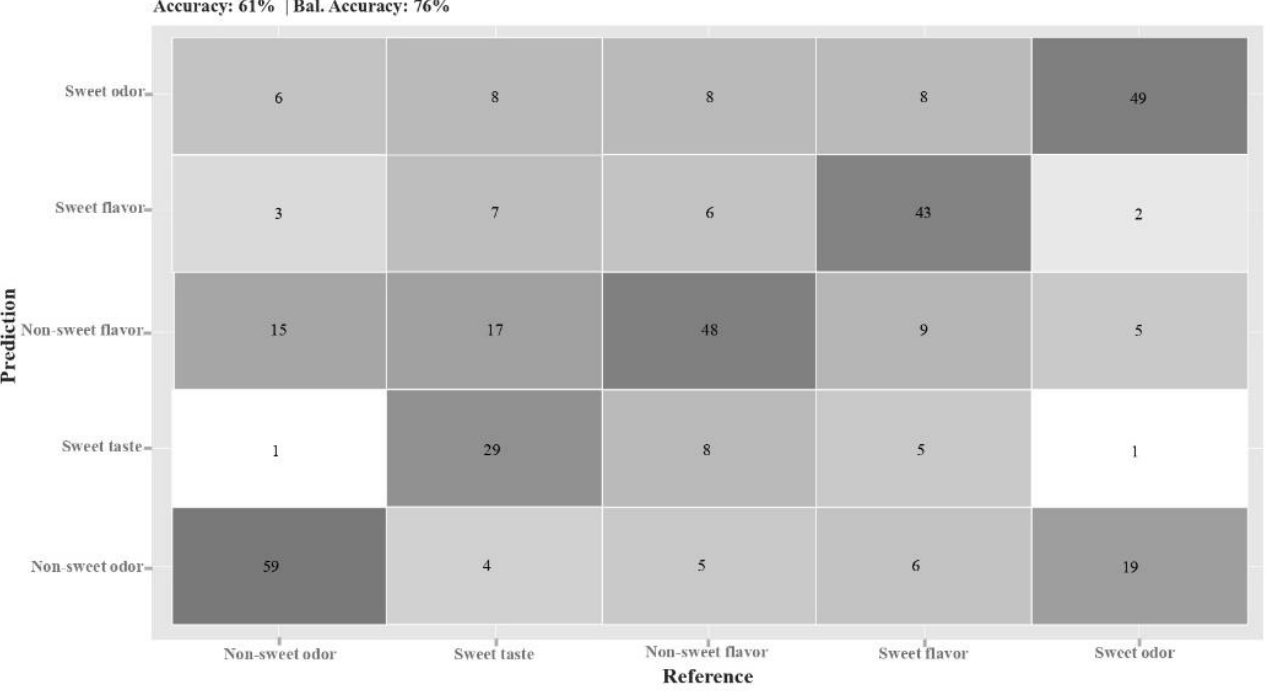
Figure 5. Confusion matrix of the descriptive model shown in Figure 4.